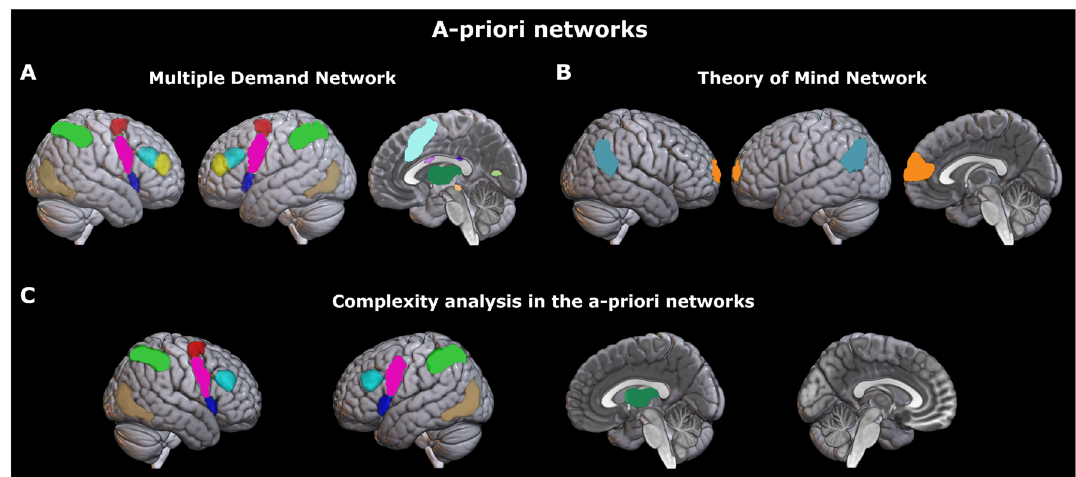
Figure 3. Effects within the multiple demand and the theory of mind networks. The effect of the environment complexity was tested in brain areas belonging either to the MDN ( A ) or the ToM network ( B ). While an effect was present in most of the MDN ROIs ( C ), it was absent in all the ToM ROIs. In the brain maps, colors are simply illustrative and define distinct ROIs in the MDN ( A ) and ToM network ( B ). For clarity, we depicted corresponding areas in the left and right hemispheres using the same color ( A , B ). ( C ) displays the ROIs from ( A , B ) in which the effect was significant (i.e., only the ROIs showing a significant effect). The color of the ROIs in ( C ) matches the color in ( A , B